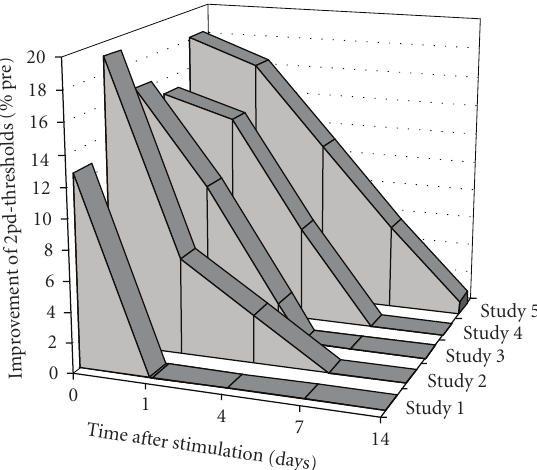
Figure 5: Stability of improvement of tactile acuity following di ff erent repetitive stimulation paradigms. The magnitude and the stability of the improvement of tactile acuity crucially depend on the stimulation protocol. Studies 1 [38], 2 [44], and 3 [43] were conducted in young subjects, whereas studies 4 [26] and 5 [the present work] were conducted in healthy elderly individuals. In studies 1, 2, and 4 an irregular stimulation was used for 3 hours, with stimuli drawn from a Poisson process and thresholded for a minimal interstimulus interval (ISI) of 100 ms, and maximal ISI of 3000 ms. Studies 3 and 5 used a high-frequency intermittent stimulation for 20 or 30 minutes, that consisted of stimulus- trains of 1s (single pulse-duration: 0.2 ms @ 20Hz) and intertrain intervals of 5s. In studies 1 and 3, stimulation was applied to a single finger (index finger), while studies 2, 4, and 5 used multifinger stimulation (data of index finger is shown here). Study 5 featured electrical instead of tactile stimulation. Missing data points (study 3: “4days”, study 5: “1day”, “4days”) were linear